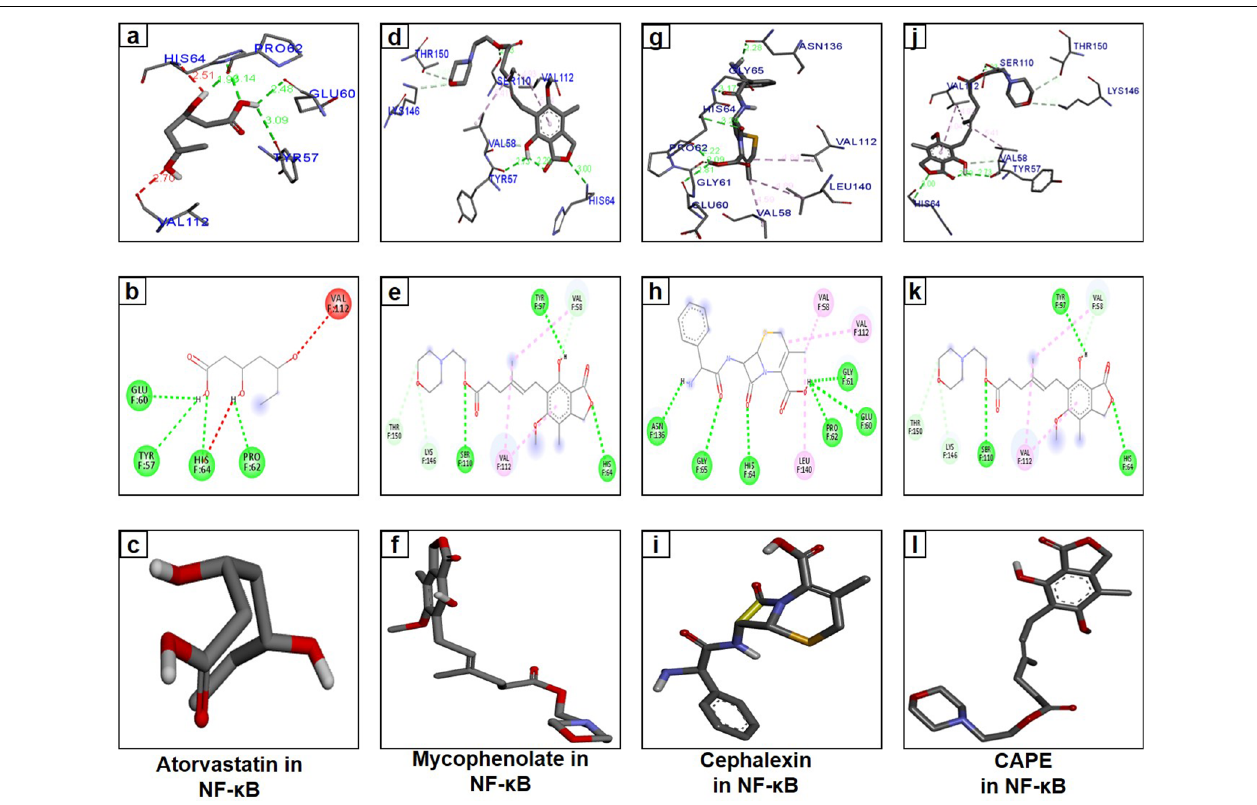
FIGURE 3 | Docking results and best pose of atorvastatin, mycophenolate, cephalexin, and CAPE. The post-docking analysis was visualized by discovery studio software (DSV) in both 2D and 3D poses. Interaction between atorvastatin and NF- κ B is shown by the panels (A,B) , mycophenolate and NF- κ B by the panels (D,E) , cephalexin and NF- κ B by the panels (G,H) , and CAPE and NF- κ B by the panels (J,K) . 3D poses are shown by panels (A,D,G,J) and 2D by panels (B,E,H,K) . Panels (C,F,I,L) represent the best pose of atorvastatin, mycophenolate, cephalexin, and CAPE fitted to the active pocket of NF- κ B. Abbreviations: TYR, tyrosine; GLU, glutamic acid; PRO, proline; HIS, histidine; SER, serine; GLY, glycine; ASN, asparagine.